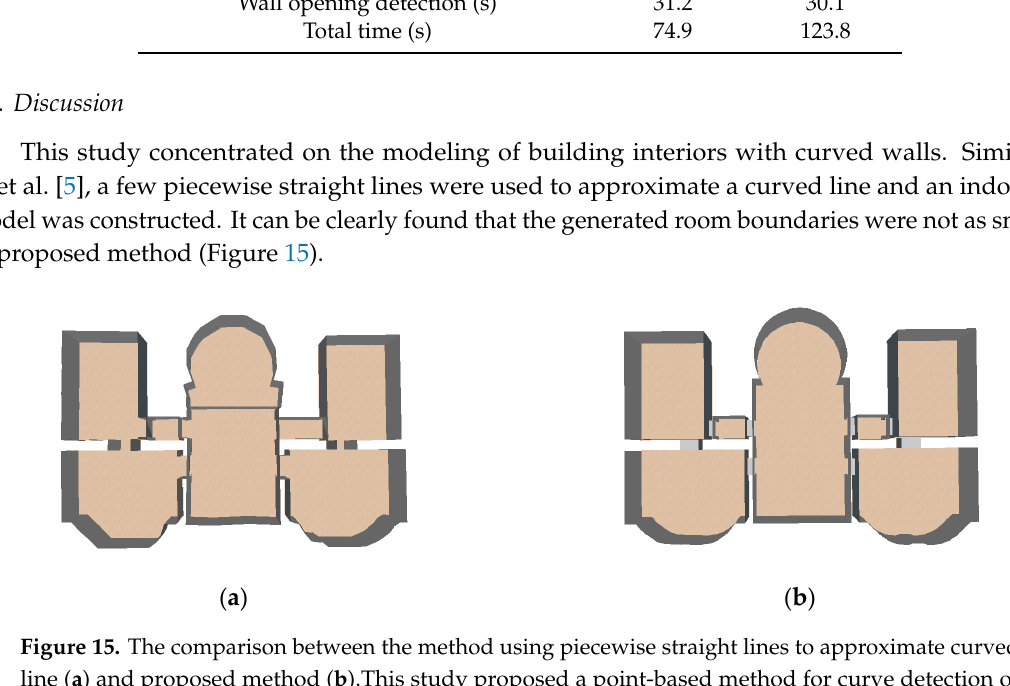
Figure 14. ( a ) Generated 3D indoor model for dataset-1; and ( b ) generated 3D indoor model for dataset-2. The ceilings are removed for clarity.